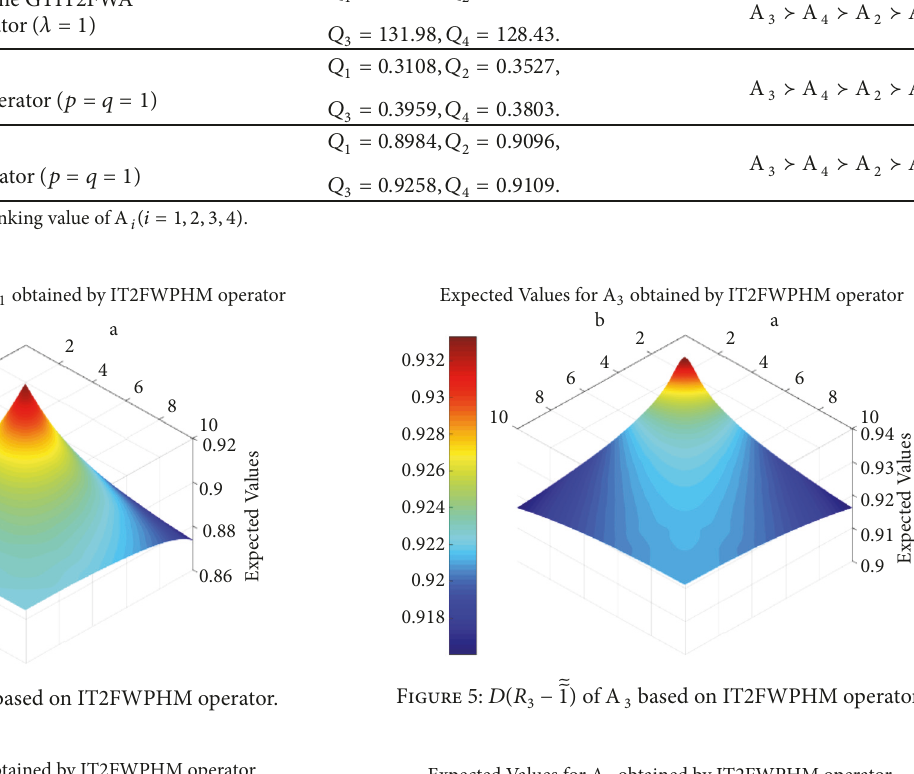
Table 5: Ranking orders of the different methods for the FELSP selection case in Section 5.1. Methods Ranking values